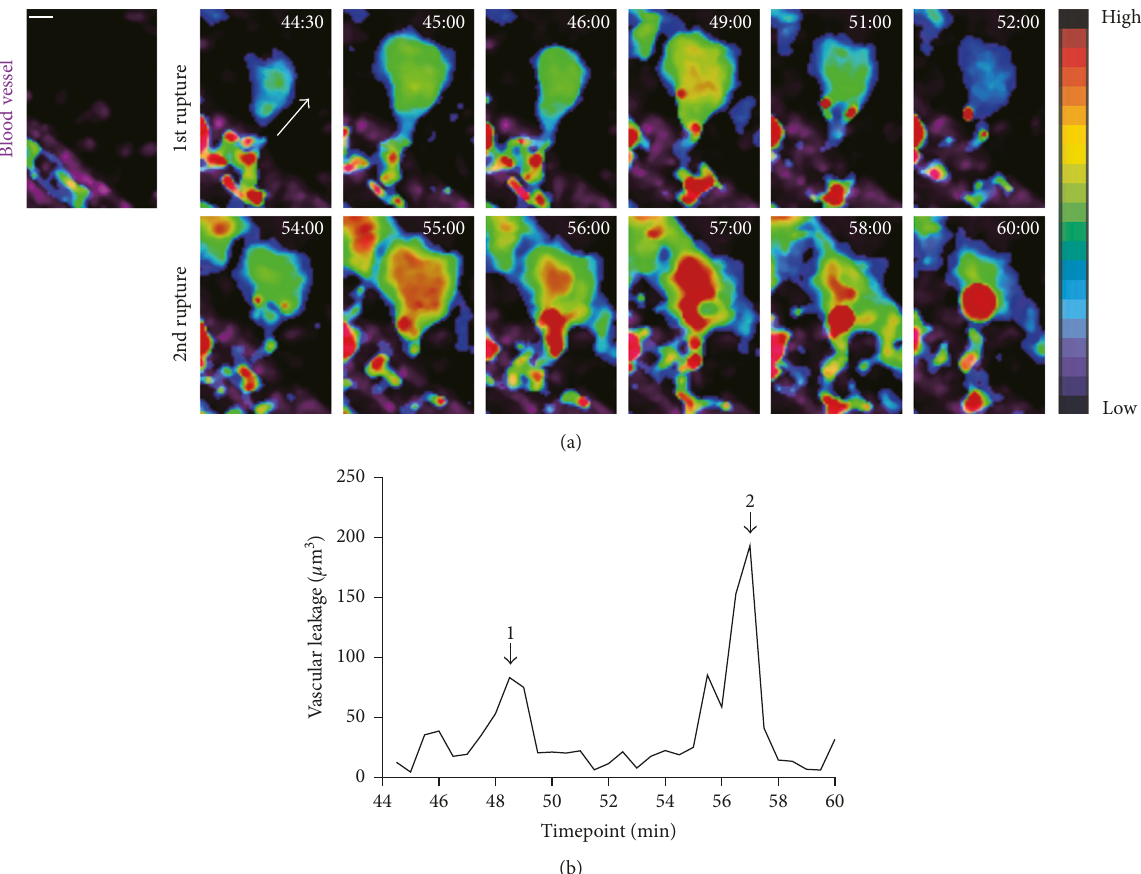
Figure 3: Leakage occurs in a repetitive and consistent manner. (a) The first image without blood leakage in S2 was set as a control condition. Color change shows the amount of leakage. Vessels appear magenta and blood flow is seen with rainbow colors. It is apparent that two disruptive events occurred within 16min. A much greater amount of leakage was observed during the second disruptive event. (b) Vascular permeability was visually demonstrated, and the graph quantitatively shows about twice as much leakage. The graphical display is consistent with transient leakage from the same site. Endothelial barrier disruption did not always result in leakage. Two arrows in the figure indicate that leakage has occurred. Graph B shows the volume of leakage measured according to site. Scale bar: 10 µ